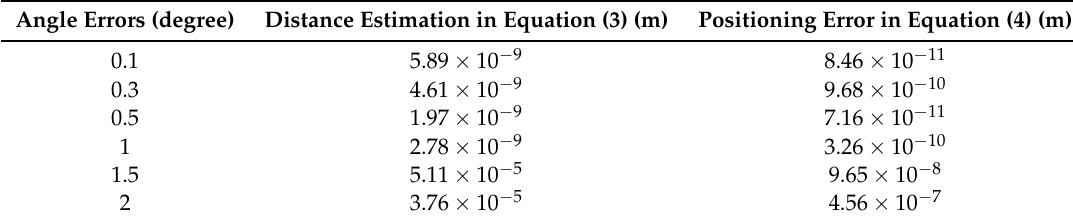
Table 2. Positioning errors regarding AS accuracy.